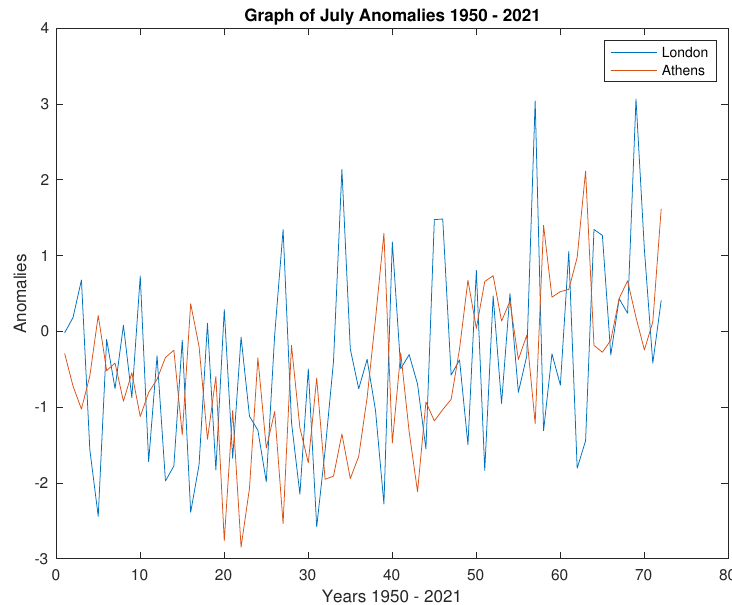
Figure 18. Graph of July Anomalies